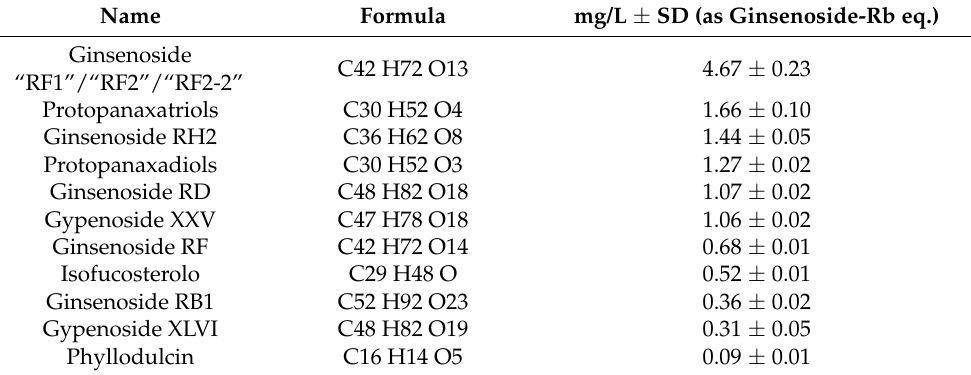
Table 1. Semi-quantification of selected saponins (as mg/L Equivalent) detected in Gynostemma pentaphyllum (var. Ginpent)